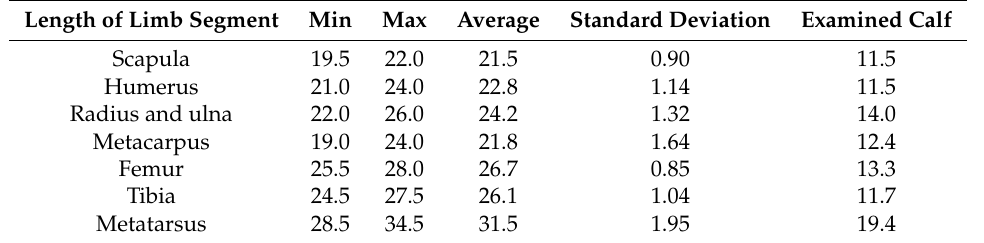
Table 1. The comparison of thoracic and pelvic limbs in 10 calves in relation to the examined calf (in